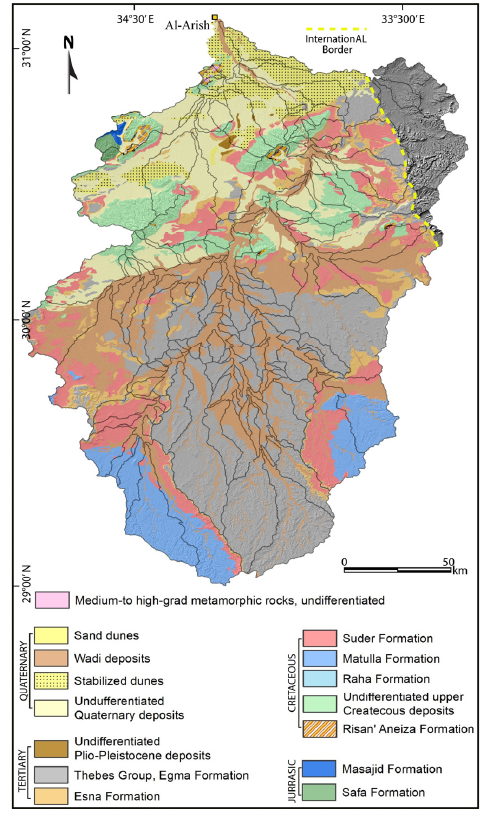
Figure 2. Detailed lithological map of the study area overlain by classified catchments/sub- catchments, modified after Reference in [18].